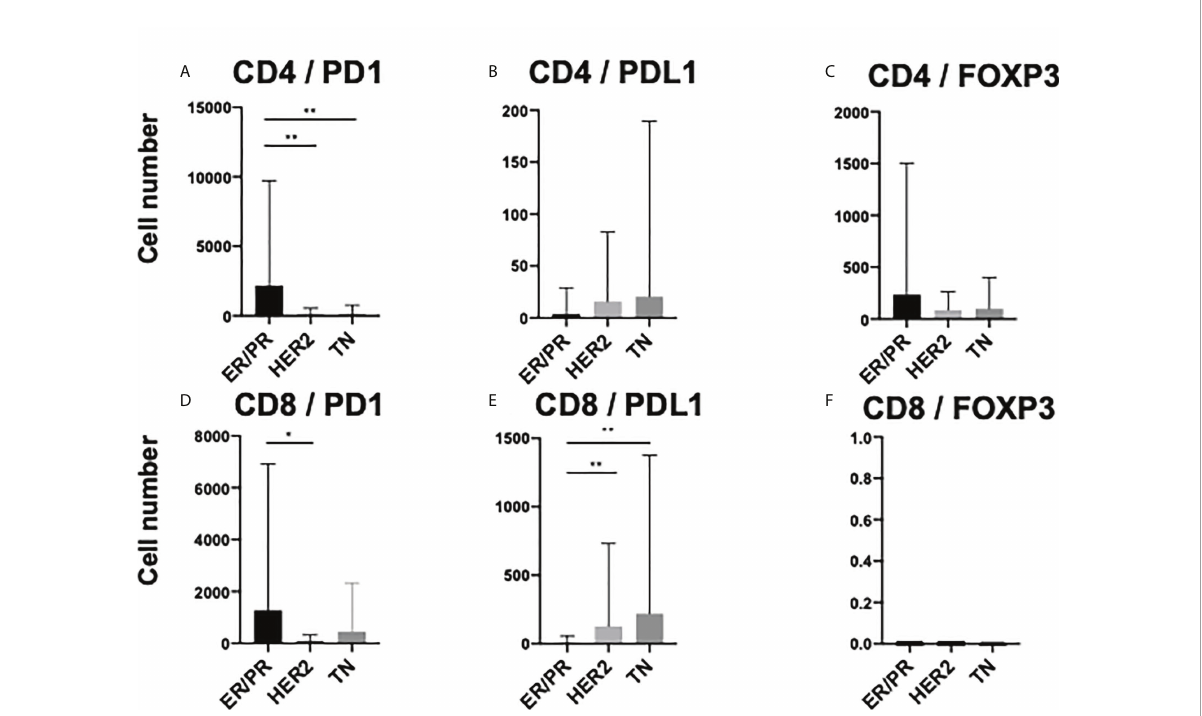
FIGURE 5 Comparison of TIL marker double-positive cells amongst intratumoral TILs (iTILs) in ER/PR, HER2, and TN subtypes. Average number of (A) CD4/PD1, (B) CD4/PDL1, (C) CD4/FOXP3, (D) CD8/PD1, (E) CD8/PDL1, and (F) CD8/FOXP3 double-positive iTILs among each subtype (ER/PR: n=46, HER2: n=18, TN: n=22). *, **, and indicate p < 0.05, p < 0.01, respectively (One-way ANOVA and Tukey ’ s multiple comparison test). Error bars represent standard deviation.